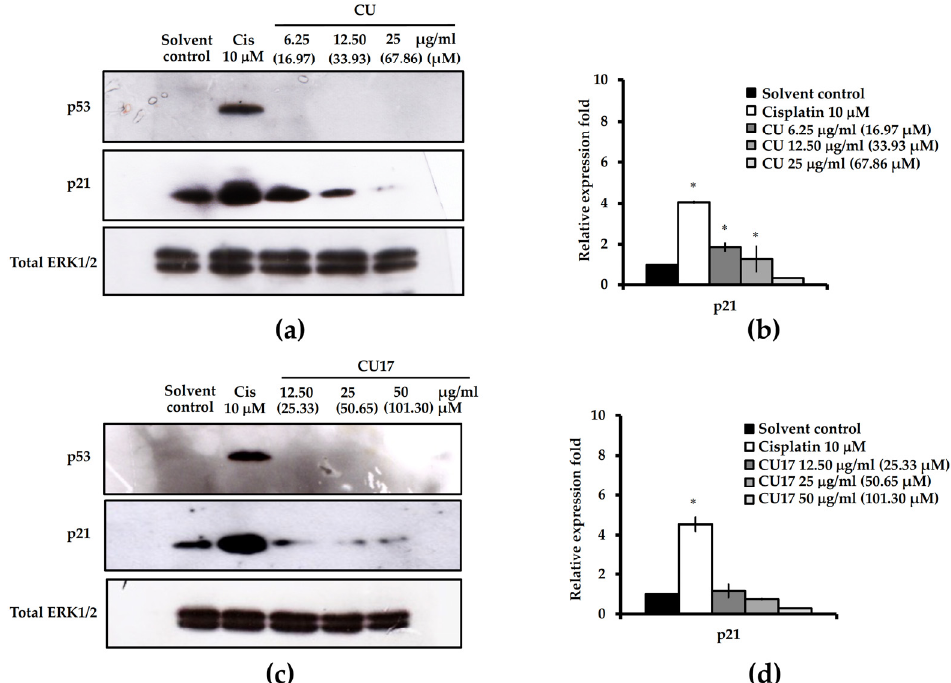
Figure 6. Western blot analysis of cell cycle-related proteins in A549 cells for 24 h exposure. ( a , c ) Expressions of cell cycle-associated proteins (p53 and p21) treated with CU or CU17 were determined, and the cells were exposed to DMSO: ethanol (1:1, v / v ) and cisplatin (10 µ M) as negative and positive controls, respectively. Total ERK1/2 was used as a loading control for Western blotting. The representative blots are from one experiment. ( b , d ) The relative fold of protein expression was calculated using the intensity of the protein band in comparison to that of a loading control and shown as a bar graph. Bar graph displayed the mean from three independent experiments. * p < 0.05 indicates a significant difference between the treatment and the solvent control.